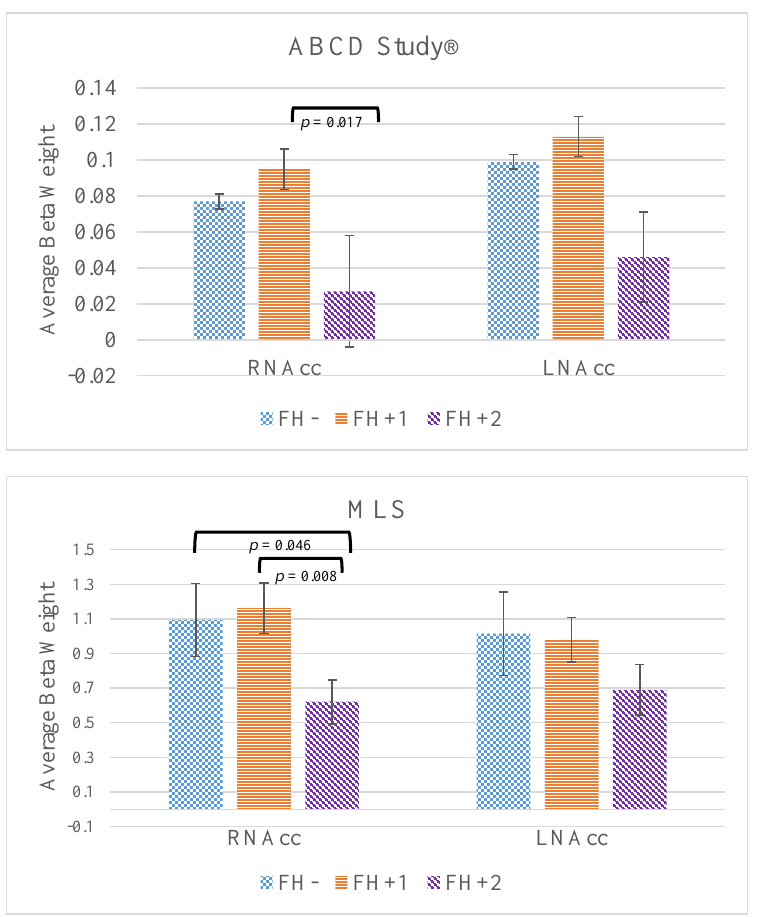
Figure 1. Right and left nucleus accumbens (NAcc) activation during the anticipation of a large rewards versus neutral contrast in the ABCD Study ® ( top ) and MLS ( bottom ). Error bars denote standard error. Table 1. Regression model results by ABCD Study ® and MLS family history groups.